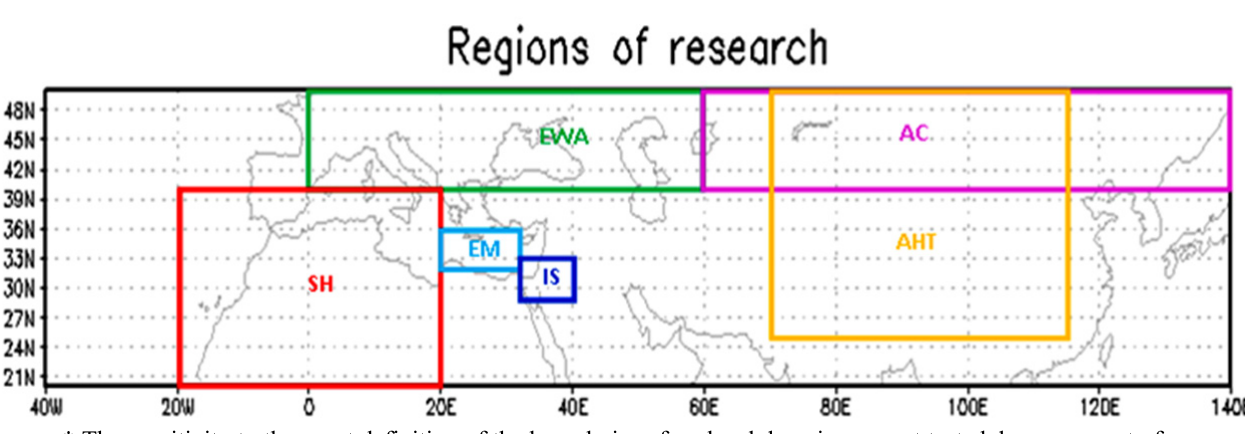
Figure 1. The research area (GLOB, 180° × 30°) and subregions. AC, Asian continental (80° × 10°), AHT; Asian high terrain (45° × 25°); EM, Eastern Mediterranean (12° × 4°); EWA, Europe and West Asia (60° × 10°); IS, Israel (8° × 4°) and the vicinity; SH, Sahara Desert (40° × 20°) *